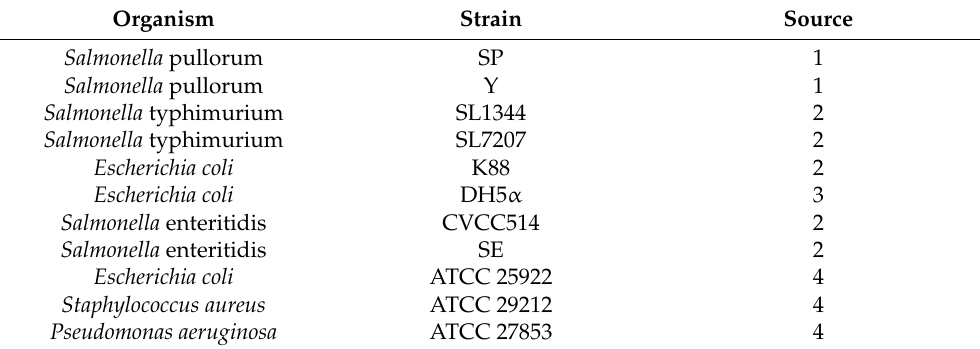
Table 1. Source of Bacterial